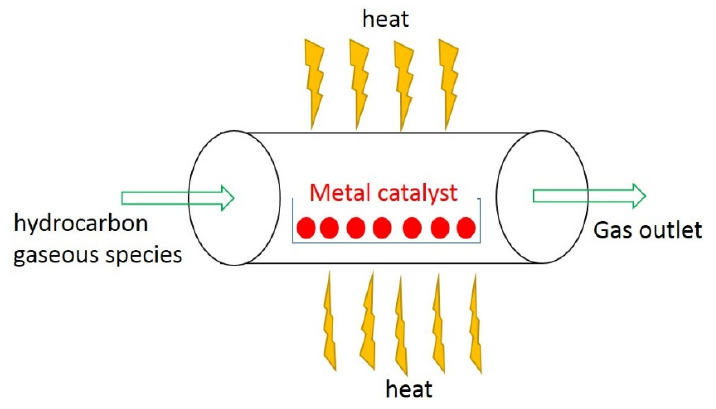
Figure 5. Schematic diagram showing CVD approach.